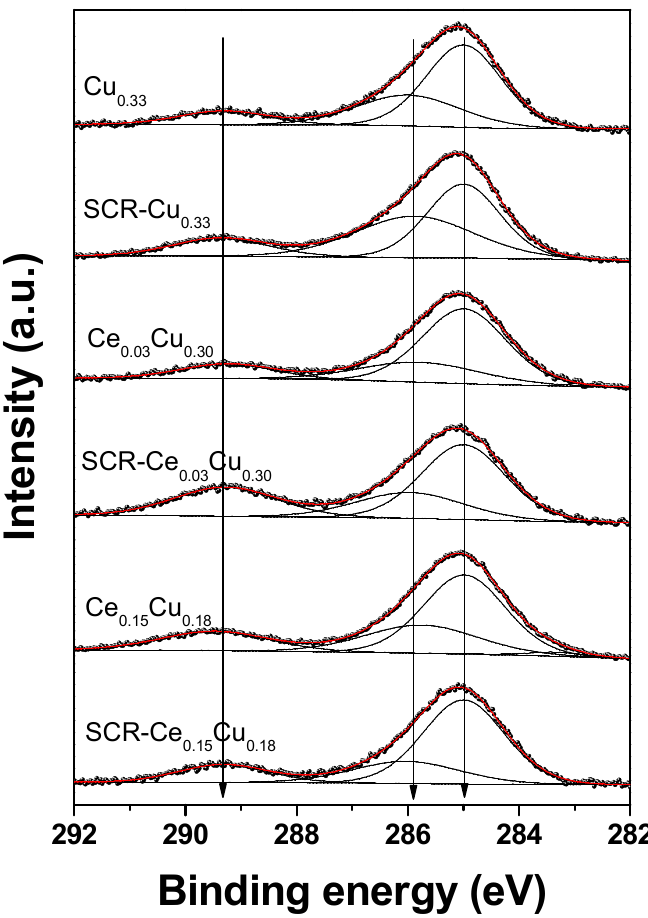
Figure 6. C 1s XPS spectra of Cu–Al parent spinels and doped with cerium for fresh and used catalysts. Three doublets were used to properly fit the Cu 2p spectra (Figure 7 and Table 4). The spin-orbit splittings of all doublets were in the range of 19.7–19.9 eV. The weakest doublet ( < 5%) with Cu 2p 3 / 2 + BE values of 930.7–931.2 eV is associated with the presence of reduced Cu and / or Cu 0 [12,19]. Such a component can be related to the limited reduction of highly dispersed small copper particles under high-vacuum conditions or to the di ff erential charging caused by some structural damages in the + spinel structure. Some additional clue to distinguish between Cu and Cu 0 species can be drawn from the copper Wagner plot [20]. The kinetic energy of maximum of Cu L 3 M 45 M 45 Auger peak was read from the survey spectra, whereas binding energy of low-energy component from the Cu 2p high-resolution spectra. The copper Auger parameter for such contribution is below 1847.6 eV for all measured samples. Thus, based on the copper Wagner plot, we can expect that a low-energy + component is related more to Cu 0 than Cu [20]. However, one can point out that such a procedure is a major approximation only and results should be treated with caution. The most intense components + + origin from the octahedral Cu 2 (932.7–932.9 eV) [21] and tetrahedral Cu 2 species (933.9–934.5 eV) [19] in Cu–Al spinel structure and / or CuO particles. The main photoelectron Cu 2p peaks are accompanied + by strong shake-up satellites confirming that copper is present in all samples as Cu 2 species